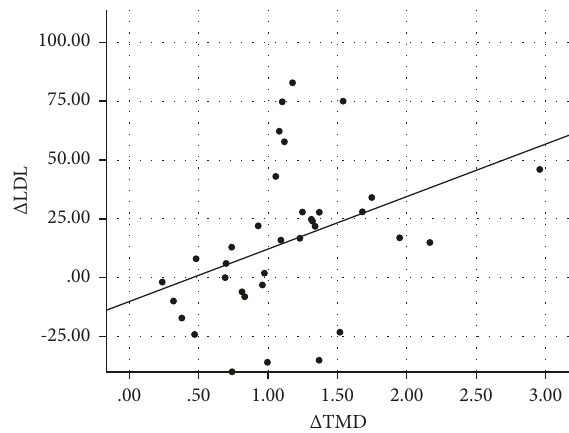
Figure 4: Scatter plot graph of